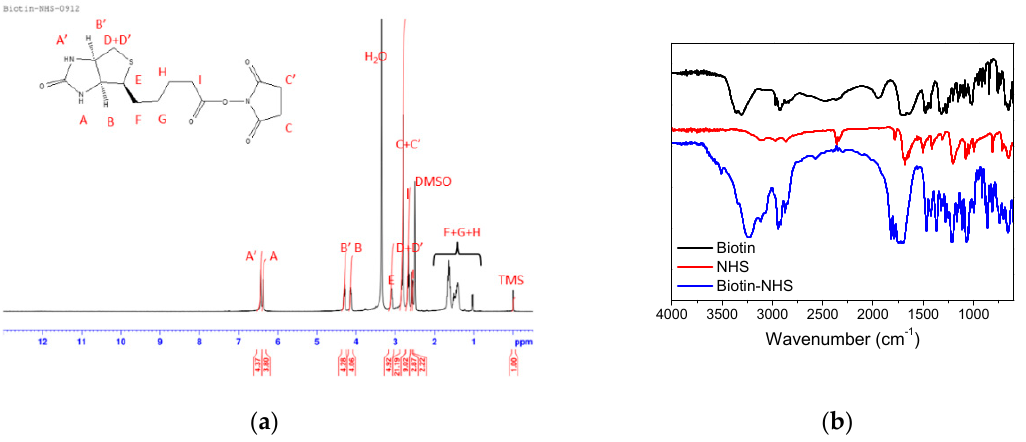
Figure 3. ( a ) 1 H NMR and ( b ) FT-IR spectra of Biotin–NHS. Table 1. Composition of BD and HBD copolymers.